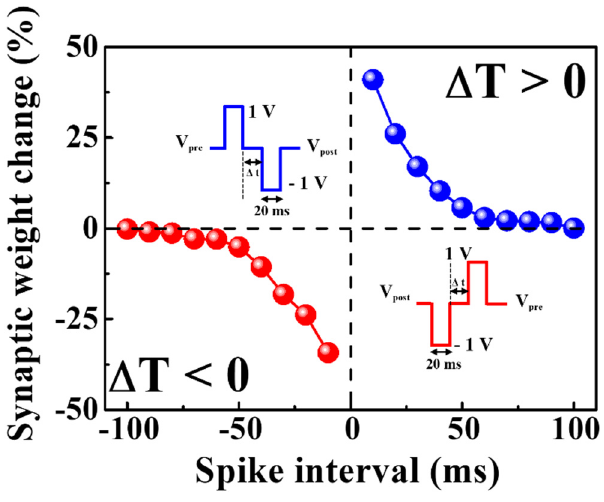
Figure 7. STDP properties for excitatory response modes. Illustrations of the spike signals are shown in the inset.